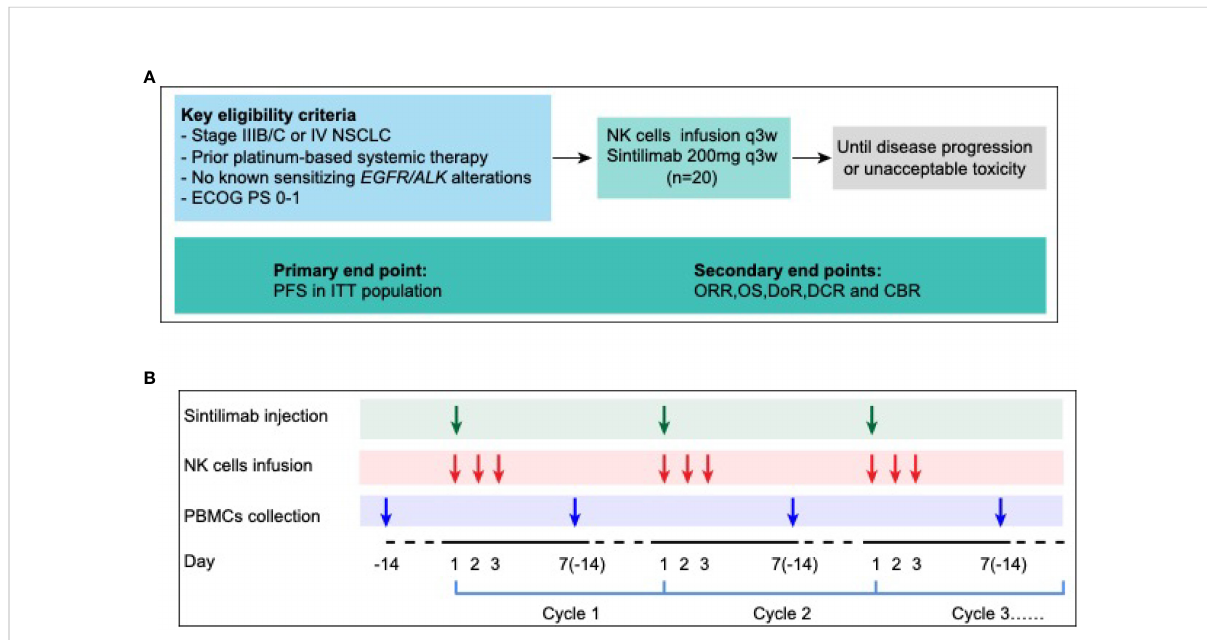
FIGURE 5 Ensemble diagram. (A) Study design. (B) Autologous PBMCs were collected by apheresis on D-14, then NK cells were isolated and cultured. 3×10 9 NK cells were divided into 3 days infusion during D1-D3, 200mg PD-1 antibody (sintilimab) was given on D1, 1 hour after NK cells infusion. NSCLC, non-small-cell lung cancer; ECOG PS, Eastern Cooperative Oncology Group performance status; PFS, progression-free survival; ITT, intention to treatment; ORR, objective response rate; OS, overall survival; DoR, duration of response; DCR, disease control rate; CBR, clinical bene fi t rate; NK cells, Natural Killer cells; PBMC, peripheral blood mononuclear